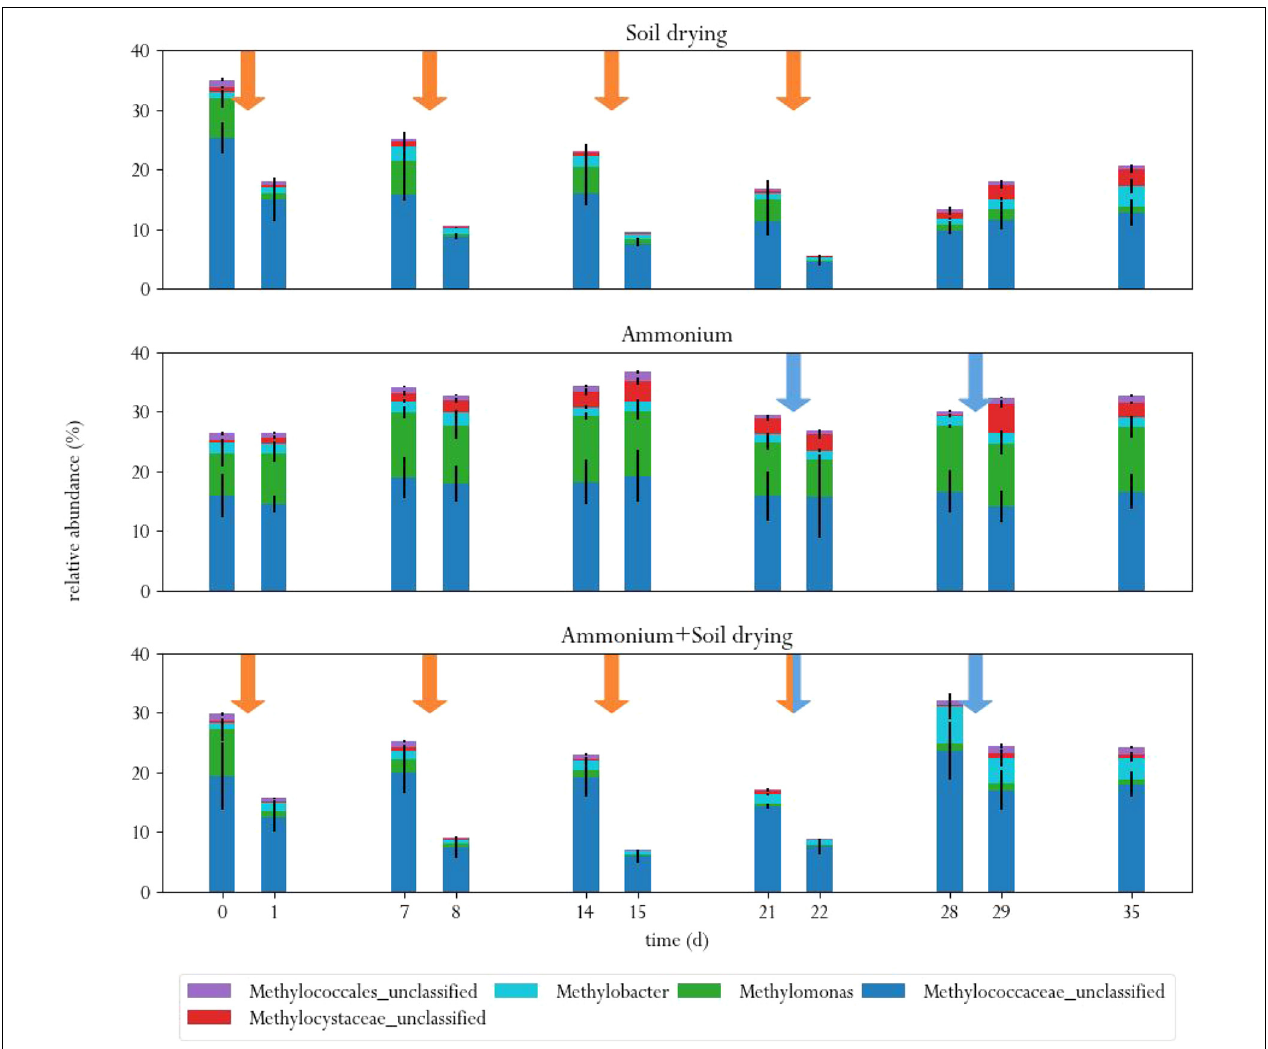
FIGURE 5 | Relative abundances of MOB in the three different treatments, before and after each perturbation. Orange arrows indicate soil drying events, blue arrows indicate ammonium addition to the corrensponding